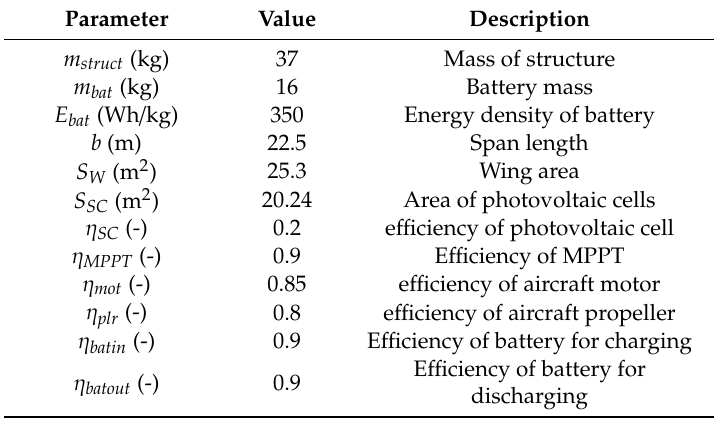
Table 2. The parameters of initial configuration for model.